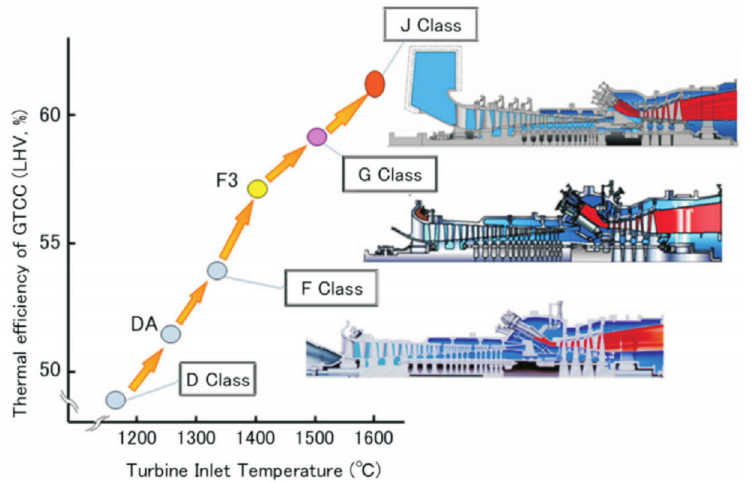
Fig. 3. Turbine classes acc. to mitsubishi Heavy Industries and equivalent efficiencies with reference to application in steam and gas systems (mHI) [8] Rys. 3. Klasy turbin według Mitsubishi Heavy Industries i odpowiadające im sprawności w odniesieniu do zastosowania w układach parowo-gazowych(MHI)